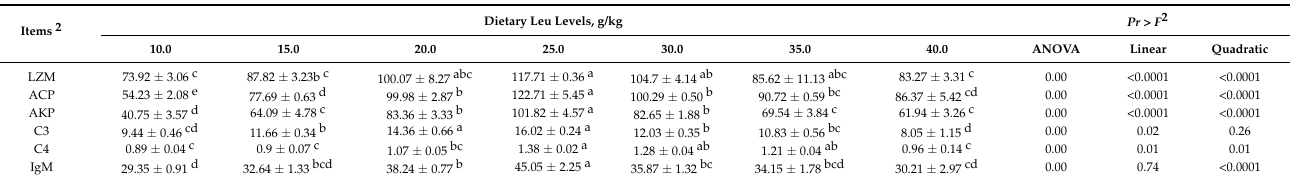
Table 1. Effects of dietary Leu on immune parameters in the intestine of hybrid catfish fed experi- mental diets containing graded levels of Leu (g/kg) for 8 weeks 1 . DietaryLeuLevels,g/kg